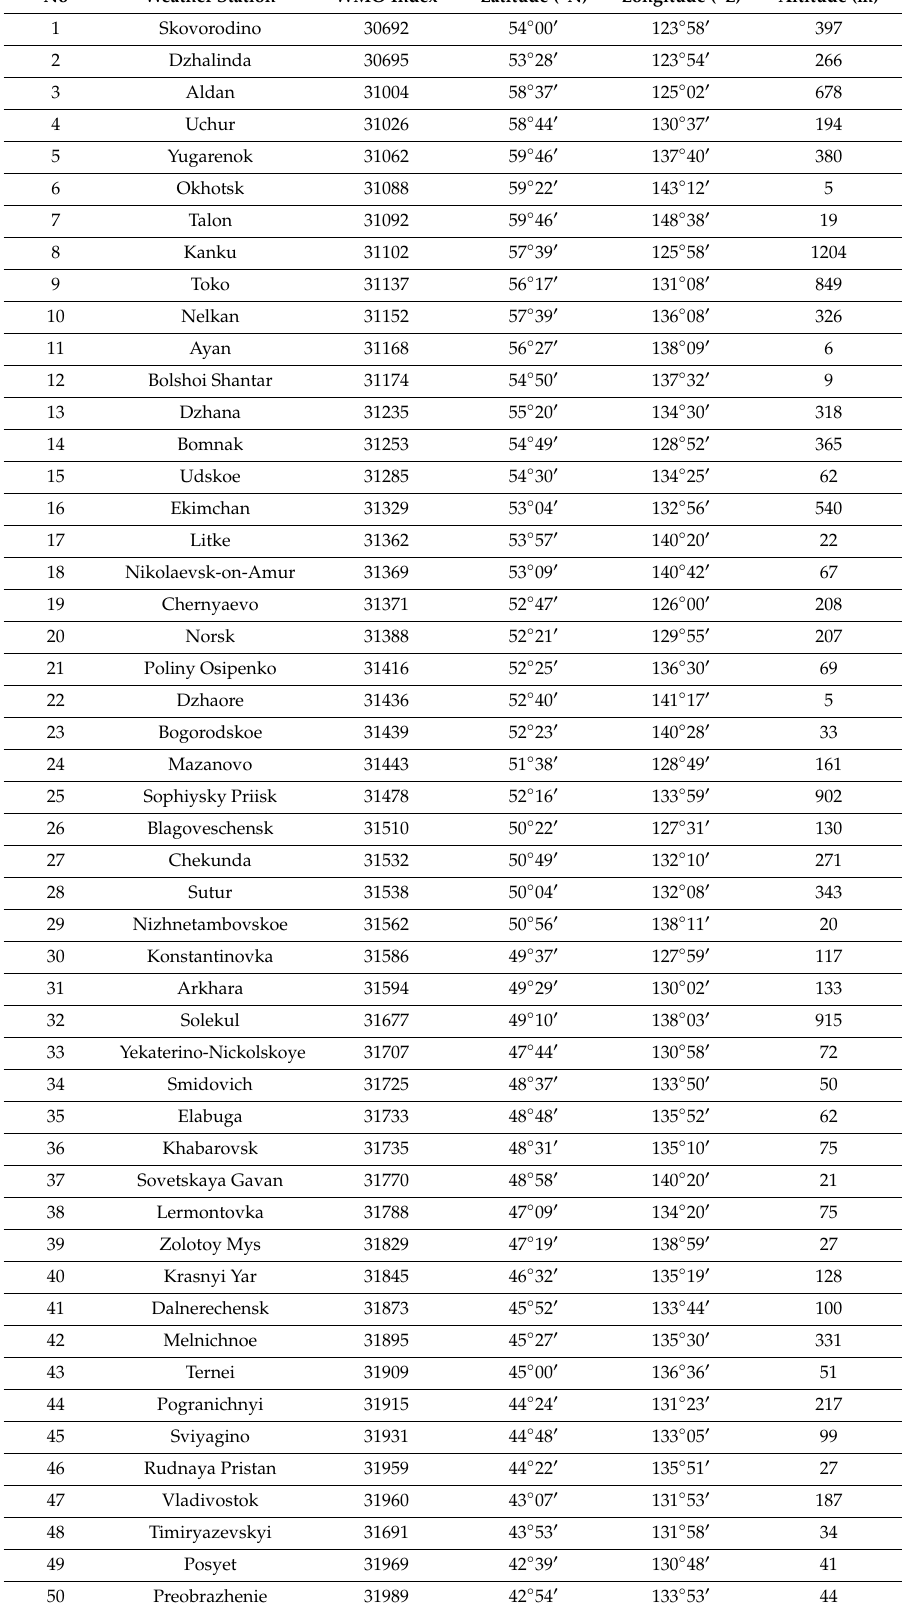
Table 1. Weather stations in the Russian Far East region used in the current